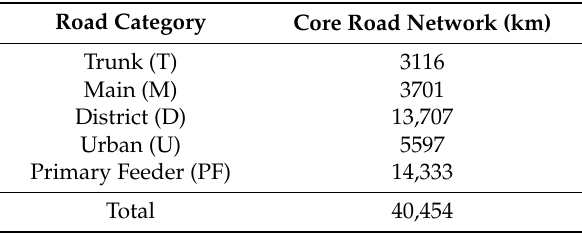
Table 1. Zambia’s Core Road Network (CRN)